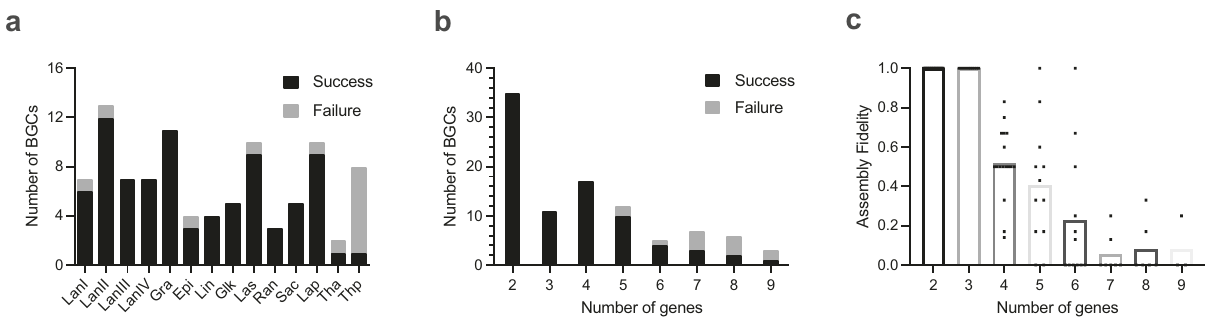
success rate and c assembly fi delity. Data are presented as the mean for assembly fi delity ( n 2 =35, n 3 =11, n 4 =17, n 5 =12, n 6 =5, n 7 =7, n 9 =6, n 8 =3,where n x